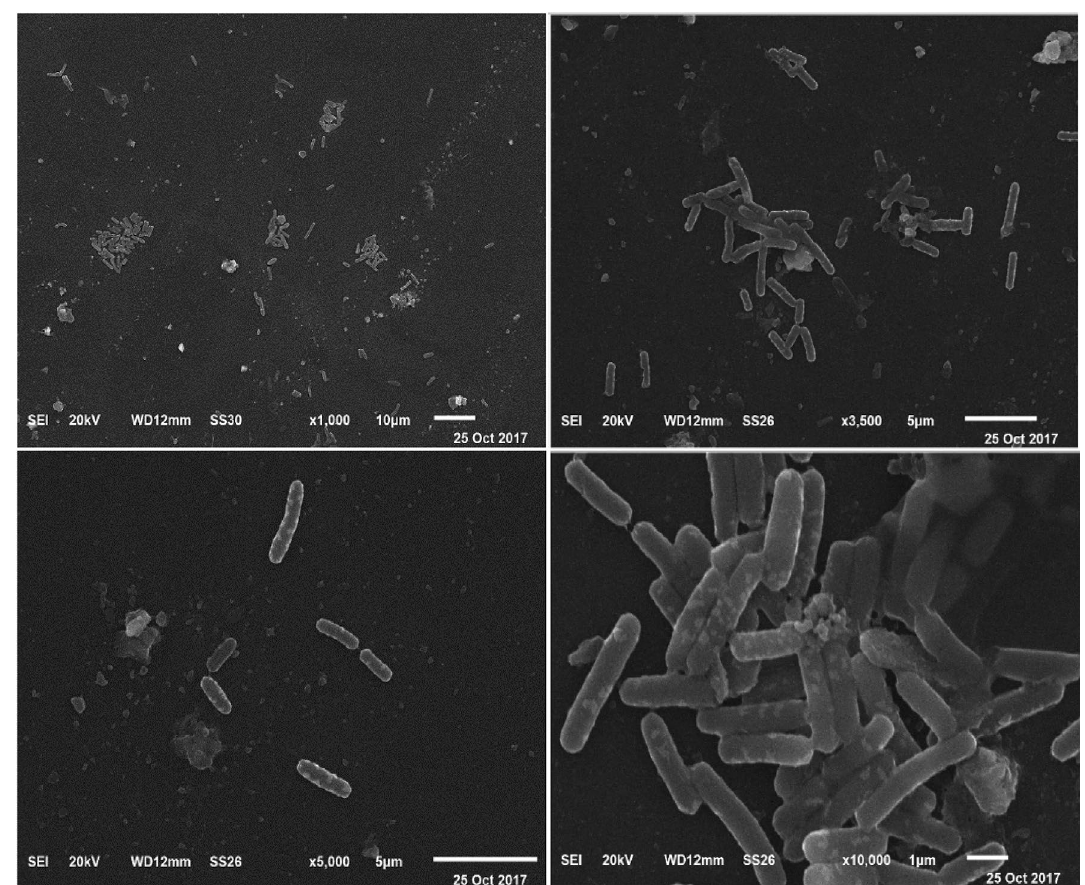
Figure 2. SEM image of Bacillus subtilis strain Fatma/1 at different